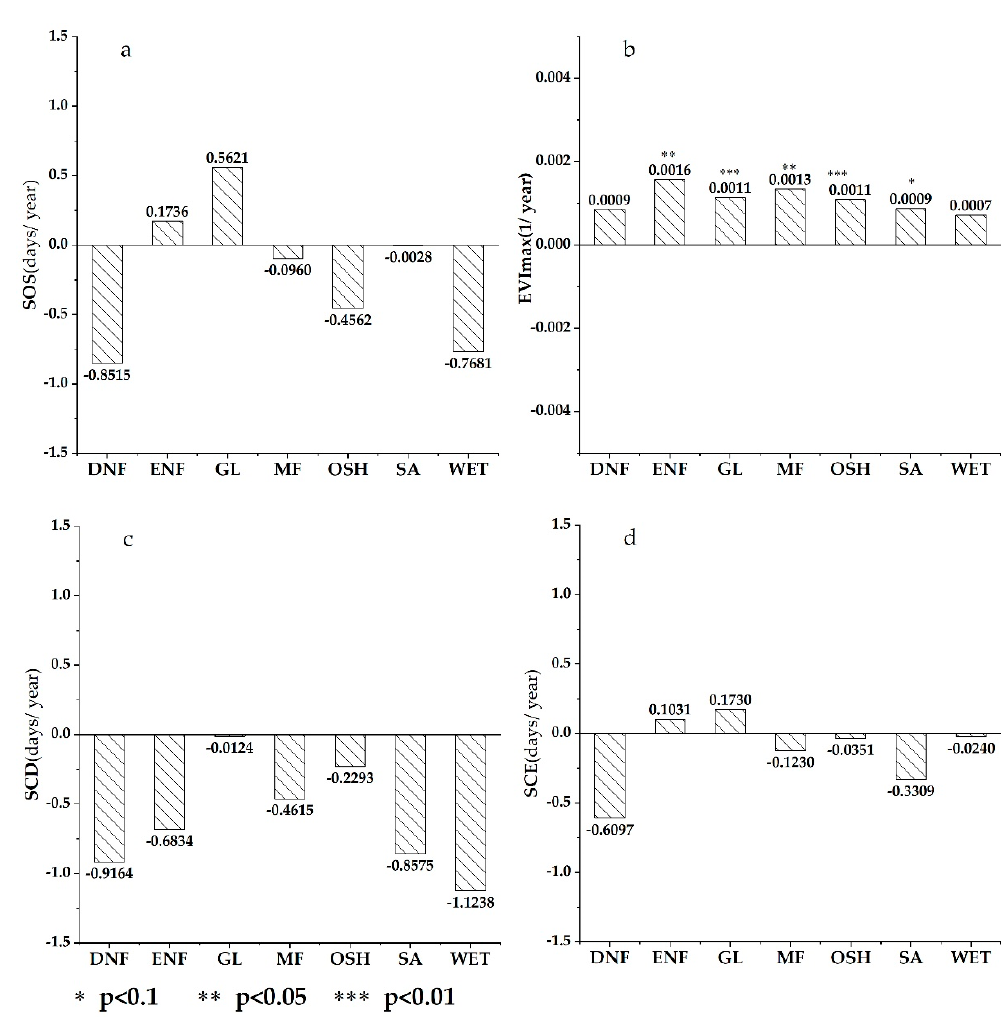
Figure 4. Temporal trends in ( a ) the start of the growing season (SOS), ( b ) annual maximum enhanced vegetation index (EVI max ), ( c ) snow cover duration (SCD), and ( d ) snow cover end date (SCE) in different vegetation types over the boreal region. DNF represents deciduous needleleaf forest; ENF represents evergreen needleleaf forest; GL represents grasslands; MF represents mixed forest; OSH represents open shrublands; SA represents savannas; WET represents permanent wetlands.